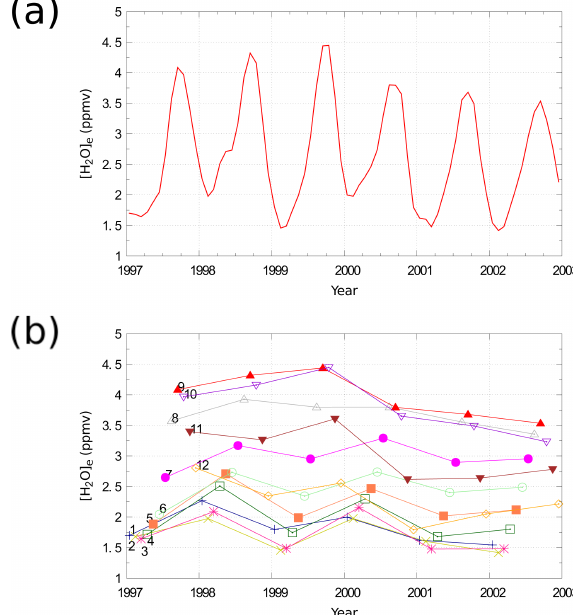
Figure 3. The time series of the ensemble mean values of [H 2 O] e (ppmv) estimated from the TST trajectories initialized on the corre- sponding month. The data points are connected by sequential month in (a) , while they are linked by each calendar month to visualize in- terannual variations on a monthly basis in (b) . The labels 1 through 12 designate January through December of each year. The signifi- cance interval at 1% level is roughly the size of each symbol in the lower